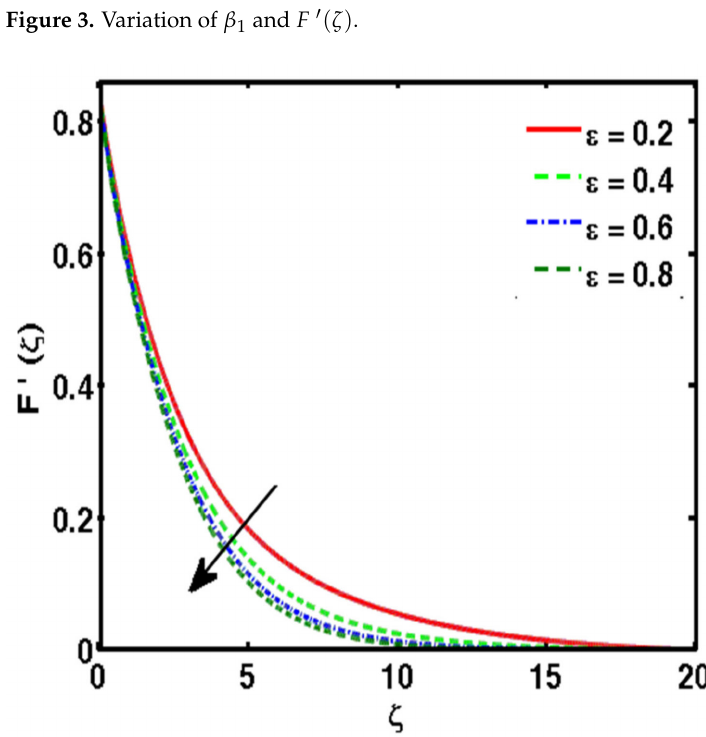
Figure 4. Variation of ε and F (cid:48) ( ζ )